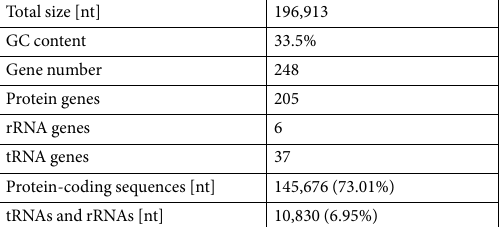
Table 1. Characteristics of the ‘Bangia’ sp. OUCPT-01